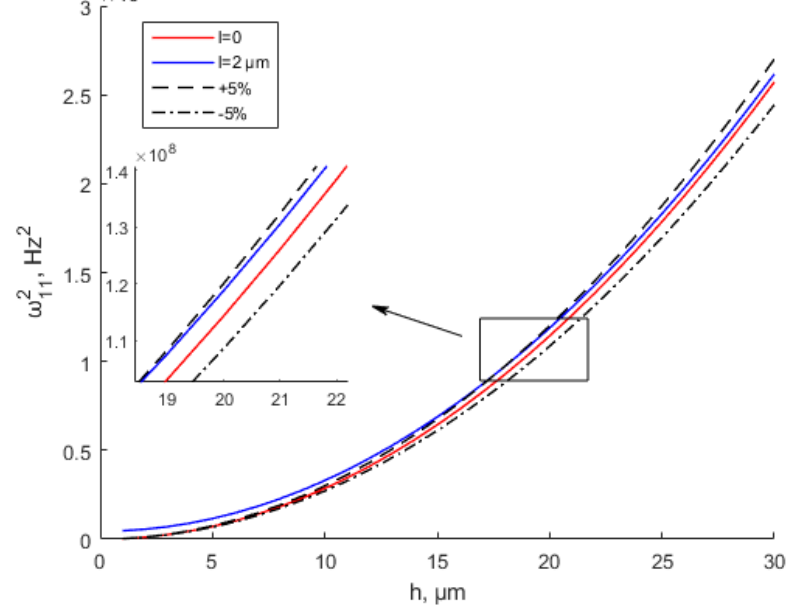
Figure 11. Modified couple stress and classical natural frequency of thin plates shown with small